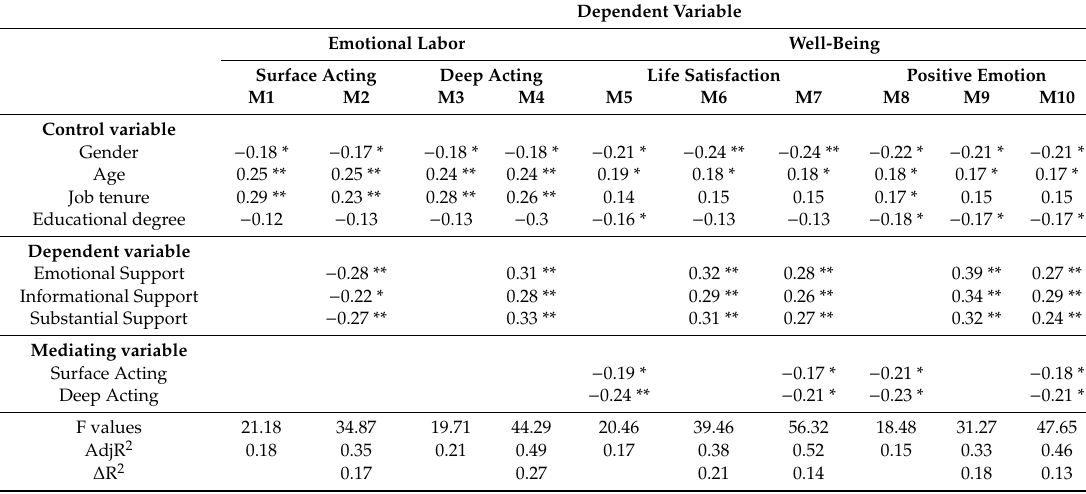
Table 3. Hierarchical regression models: The mediating e ff ect of emotional